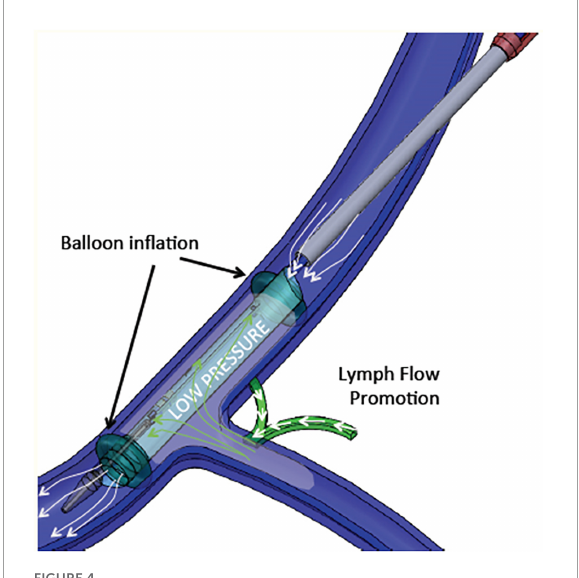
FIGURE4 WhiteSwell System mechanism of action. The system promotes fluid movement from the thoracic duct into the internal jugular vein. Polyurethane balloons mounted on the catheter are inflated to isolate the subclavian vein from the internal jugular vein. As the balloons are inflated, an inner membrane is expanded, providing a lumen for blood flow through the jugular vein between the inflated balloons. Suction is applied to the isolated area between the two inflated balloons, which creates a low-pressure zone (2–5 mmHg) between the inflated